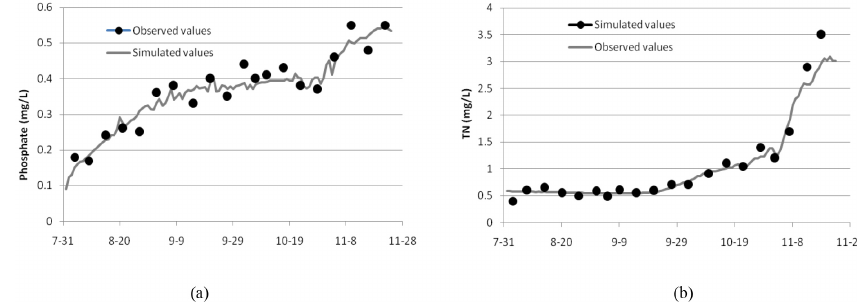
Figure 11. Validation results for phosphate (a) and TN (b) at site